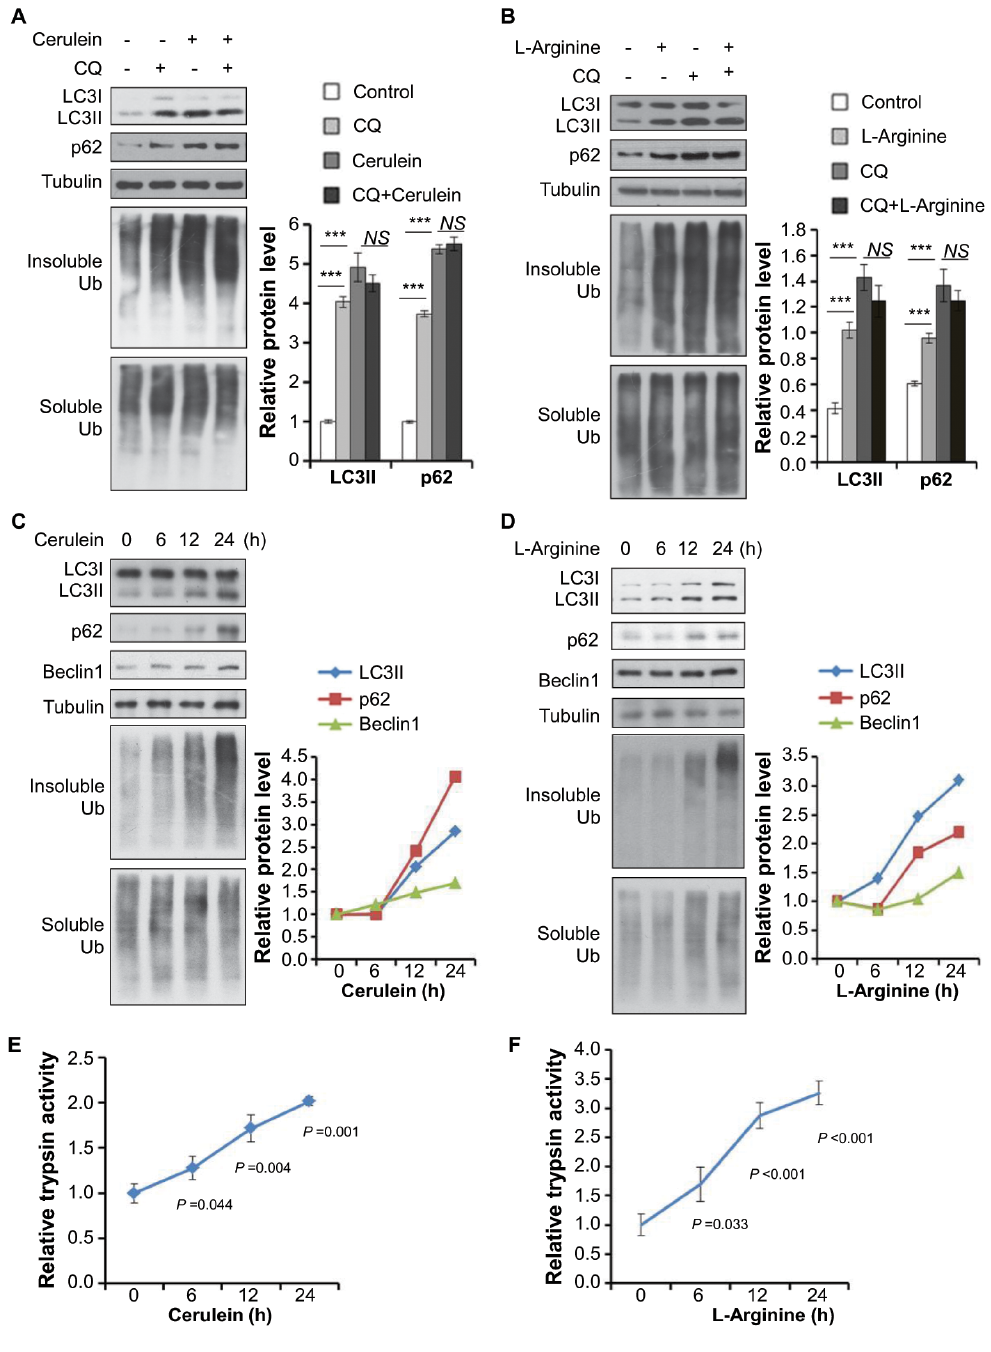
Figure 1. Cerulein or L-arginine inhibiting autophagy flux correlates with trypsinogen activation in pancreatic acinar cells. (A, B). AR42J cells were treated with 200 nmol/L cerulein (A) or 10 mmol/L L-arginine (B) for 22 h followed by chloriquitone (CQ) or normal saline treatment (Control) for two hours. The levels of LC3II, p62 and ubiquitination (Ub) were next analyzed using the Western blotting technique. The graphs provided are quantified using ImageJ as means ± SD of three independent sets of experiments. Student t test was used. *** P < 0.001. (C–F) AR42J cells were treated with 200 nmol/L cerulein (C, E) or 10 mmol/L L-arginine (D, F) for indicated durations. The levels of LC3, p62, beclin1 and Ub were next analyzed using the Western blotting technique (C, D), and the corresponding graphs (right line graphs) were quantified using Image J from two independent sets of experiments (C, D). Error bars represent SD. The relative trypsin activity was evaluated by the fluorescence intensity. Student t test was used as statistical analysis from three independent sets of experiments (E,